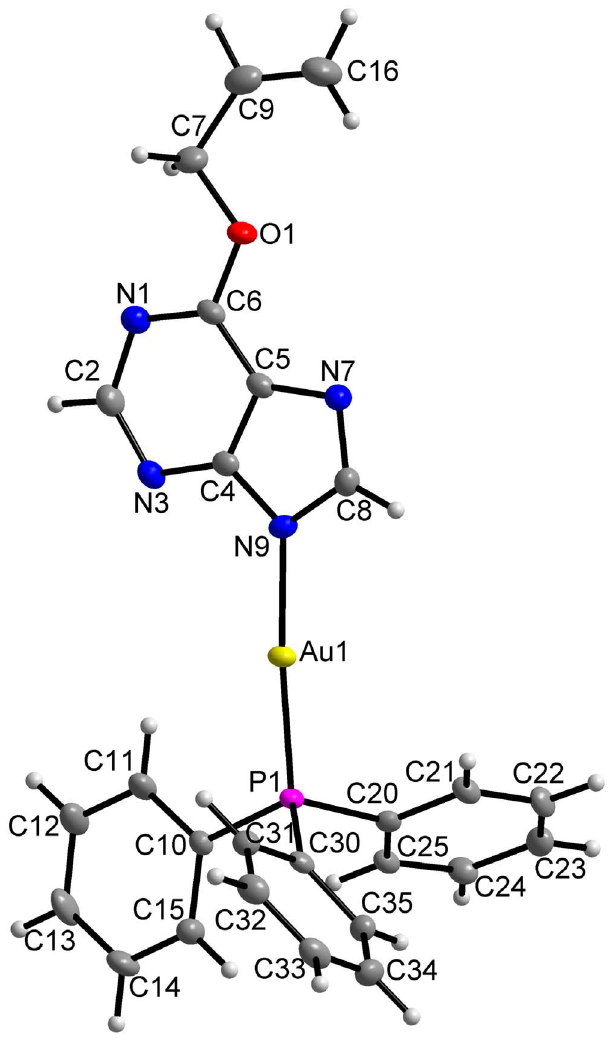
Figure 4. Molecular structure of [Au(L 3 )(PPh 3 )] (3). The molecular structure of 3 showing the atom numbering scheme. Non-hydrogen atoms are displayed as ellipsoids at the 50% probability level.